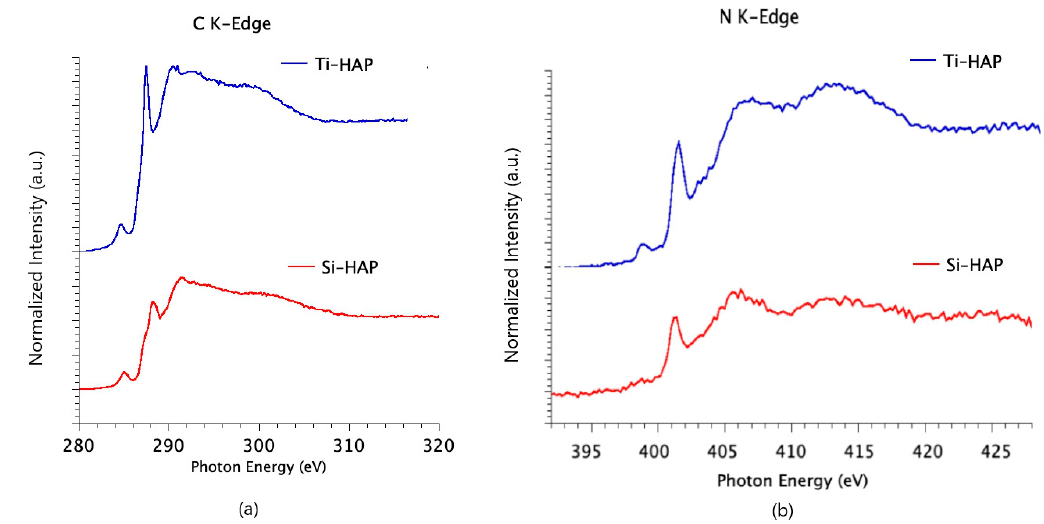
Figure 5. C K-edge ( a ) and N K-edge ( b ) NEXAFS spectra of Ti-HAP and Si-HAP after incubation with SAP solution at pH = 4, collected at magic incidence angle of 54.7°.